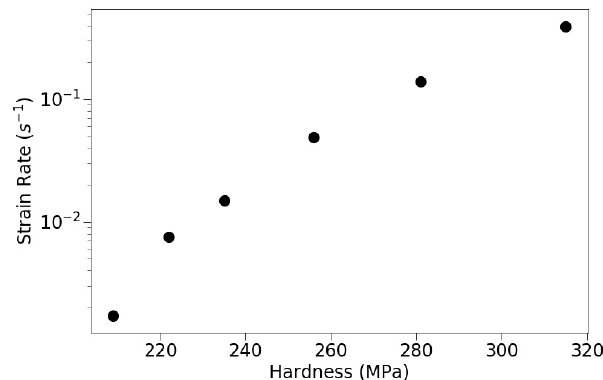
Figure 3. Plot of steady-state hardness vs. indentation strain rate for 6 target strain rates. Each data point was selected for a depth of 4000 nm, where the indentation-size effect, prominent at shallower depths, is negligible. Error bars representing the variation between all experiments at a given strain rate are smaller than the data points. The stress exponent, i.e., the slope of a line approximately through the data points in the figure, is ~25, indicating that plasticity is the dominant deformation mechanism at these conditions.